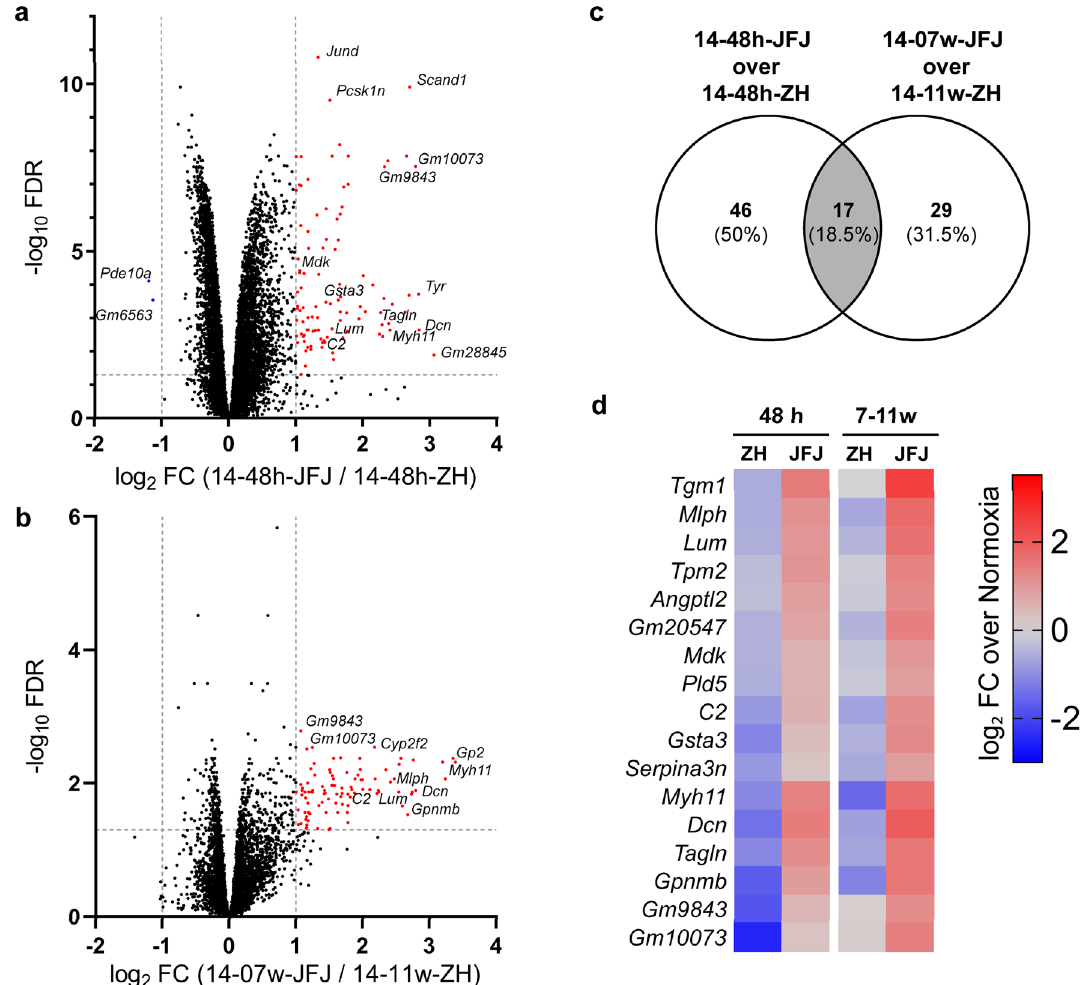
Figure 3. Differentially expressed genes after exposure to normobaric or hypobaric hypoxia. Volcano plots representing up-regulated (red) and down-regulated (blue) genes comparing ( a ) acute exposure (14-48 h-JFJ to 14-48 h-ZH) and ( b ) prolonged exposure (14-07w-JFJ to 14-11w-ZH) to hypobaric and normobaric hypoxia. Threshold limit lines are set at FDR of 0.05 and log 2 FC of ± 1. ( c ) Venn diagram showing differentially regulated genes at each time-point and their overlap (grey). ( d ) Heatmap of the 17 shared genes identified in (c). Shown are up- (red) and down- (blue) regulated genes as log 2 fold change (FC) over normoxia in the short- or long- term groups as